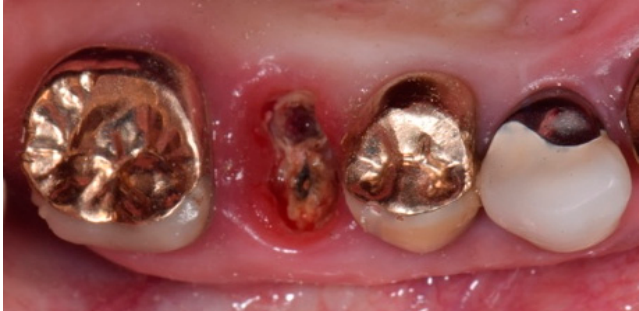
Figure 2. Intra-oral clinical picture after the crown removal, showing the fracture of upper right second premolar (1.5 teeth).